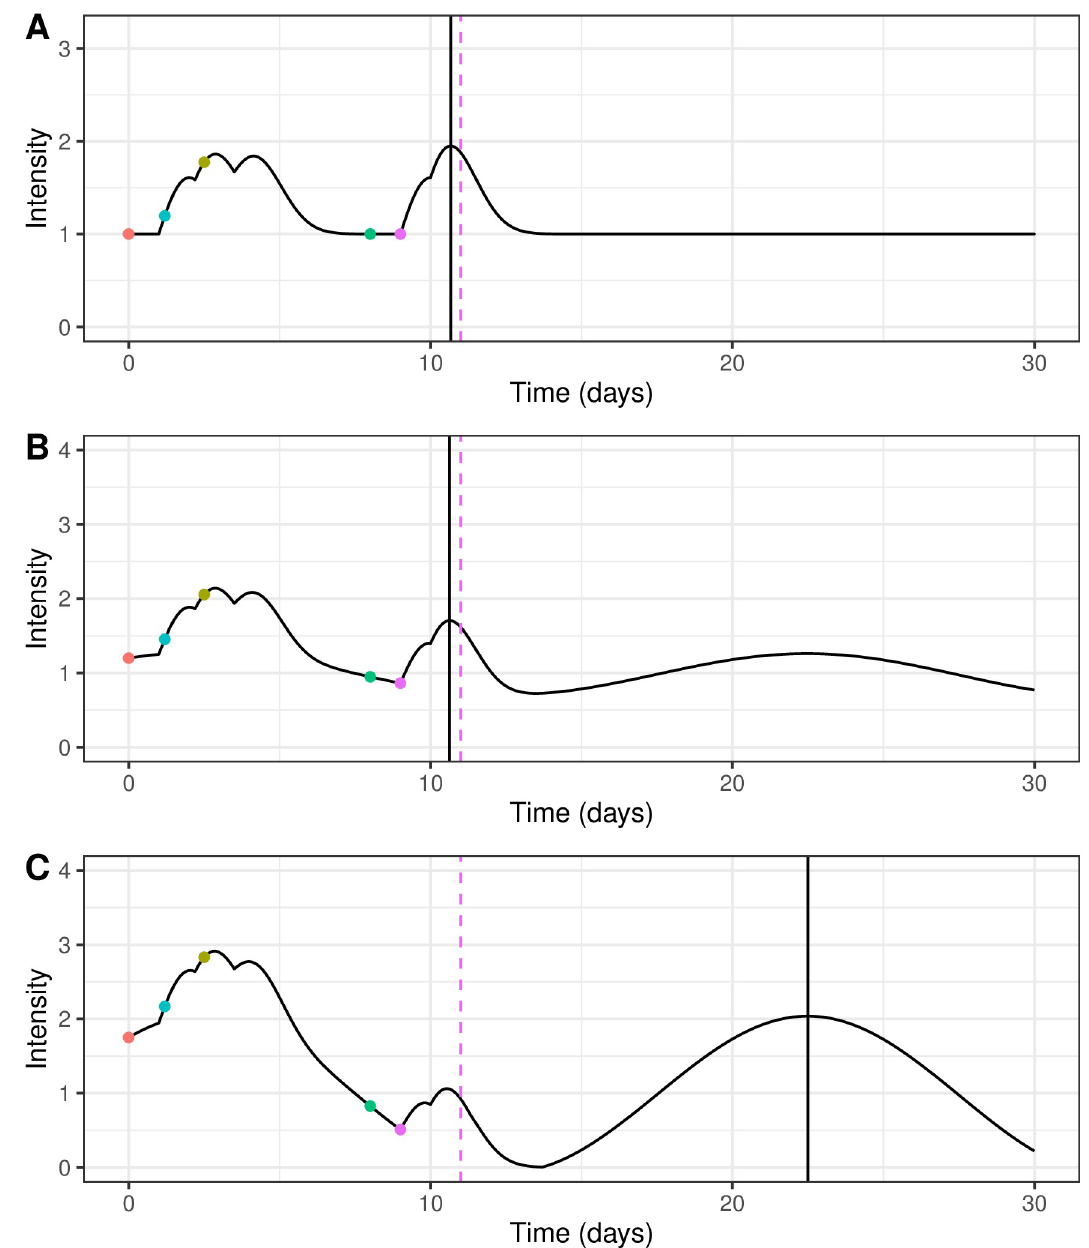
Fig 1. Illustrative plot of intensity function for events occurring at times 0, 1.2, 2.5, 8 and 9 with kernel parameters α = 1.0 and δ = 1.0, a 1 day delay and a time varying μ . The coloured dots refer to different events or infections and the dashed pink line indicate the time of the theoretical maximum value of a single Rayleigh kernel at the last event time. The solid black line indicates the time of the maximum value of the kernel after the last event. Fig 1A shows a constant μ and Fig 1B and 1C show sinusoidal μ with a linear decrease of different magnitudes. The parameters for Eq (6) in each case are as follows: A— A = 1; B— A = 1, B = − 0.001, M = 0.2, N = 0.2 and p = 20; C— A = 1, B = − 0.001, M = 0.75, N = 0.75 and p = 20. These parameters are only illustrative and do not reflect parameters we would expect real in malaria